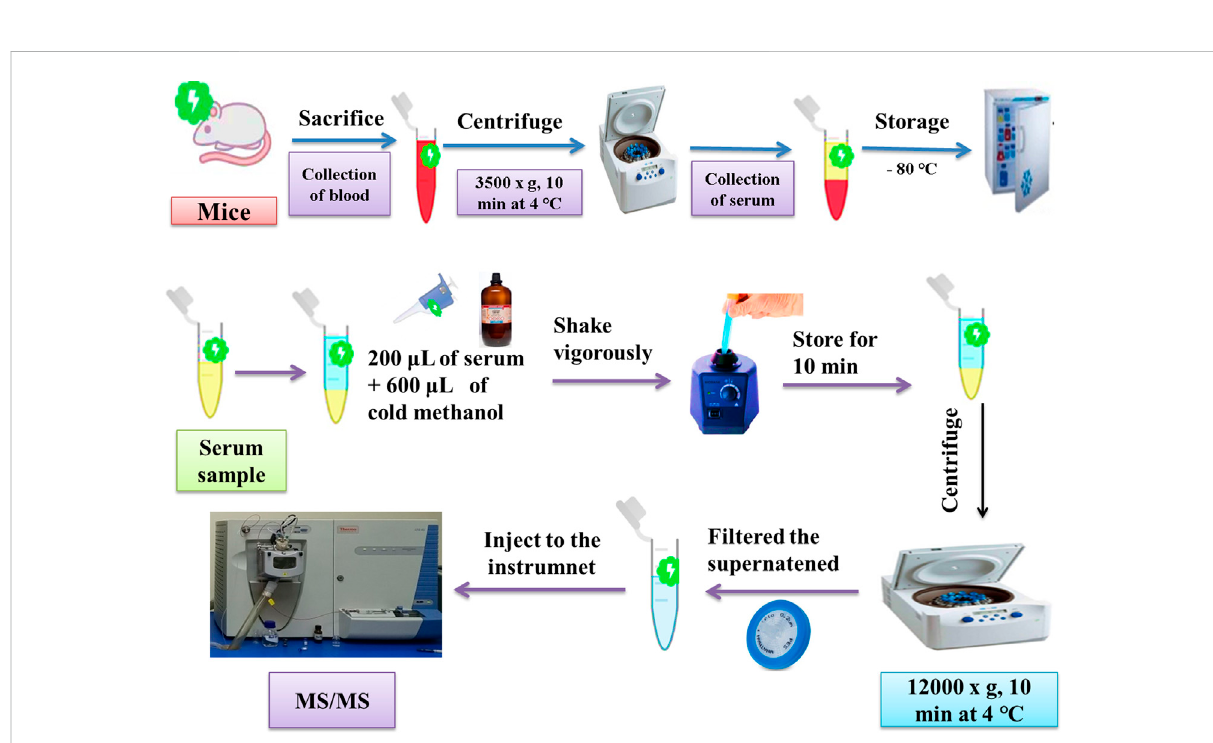
FIGURE 2 Schematic representation of serum separation and sample pretreatment for metabolite acquisition by MS/MS.